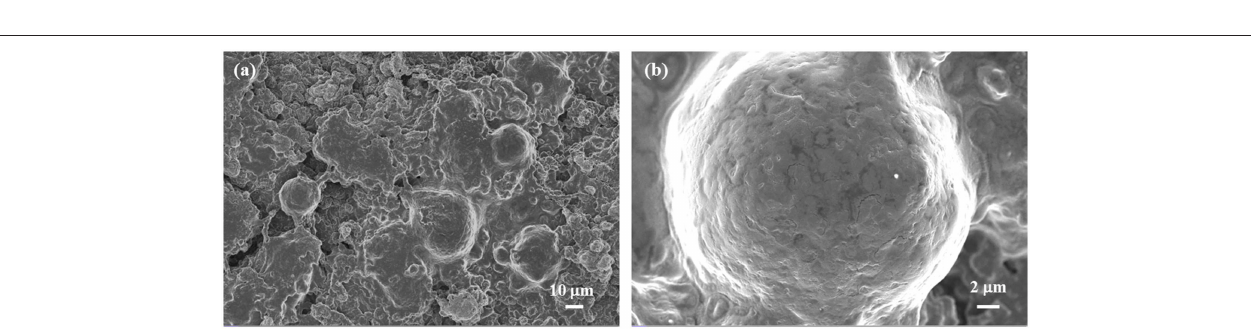
FIGURE 5 | (a) Low magnification and (b) high magnification SEM images of the LLOs/CNTs/NFCs electrode after 100 cycles at 1C.